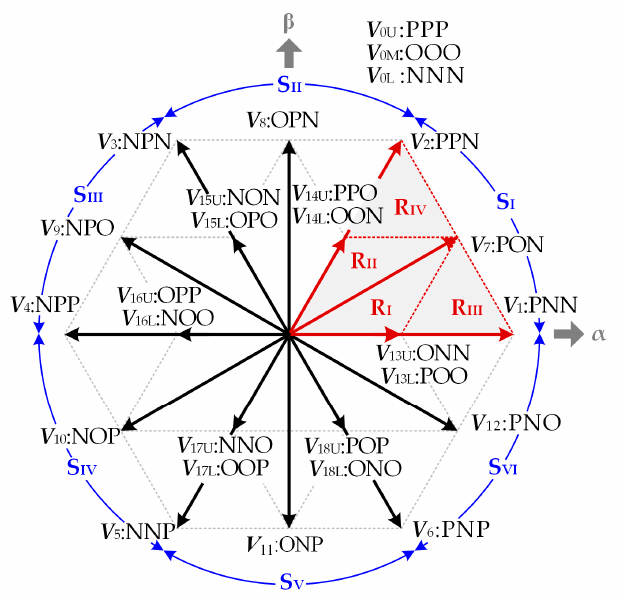
Figure 2. The space vector diagram of the NPC three-level inverter.